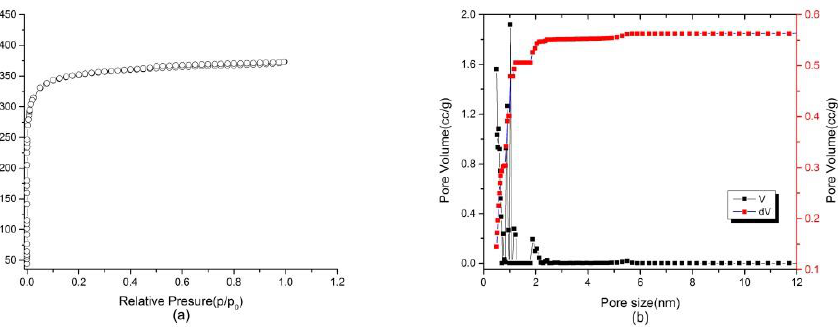
Figure 4. ( a ) N 2 adsorption – desorption isotherms of activated carbon fiber (ACF); and ( b ) ACF’s pore size distribution curve.